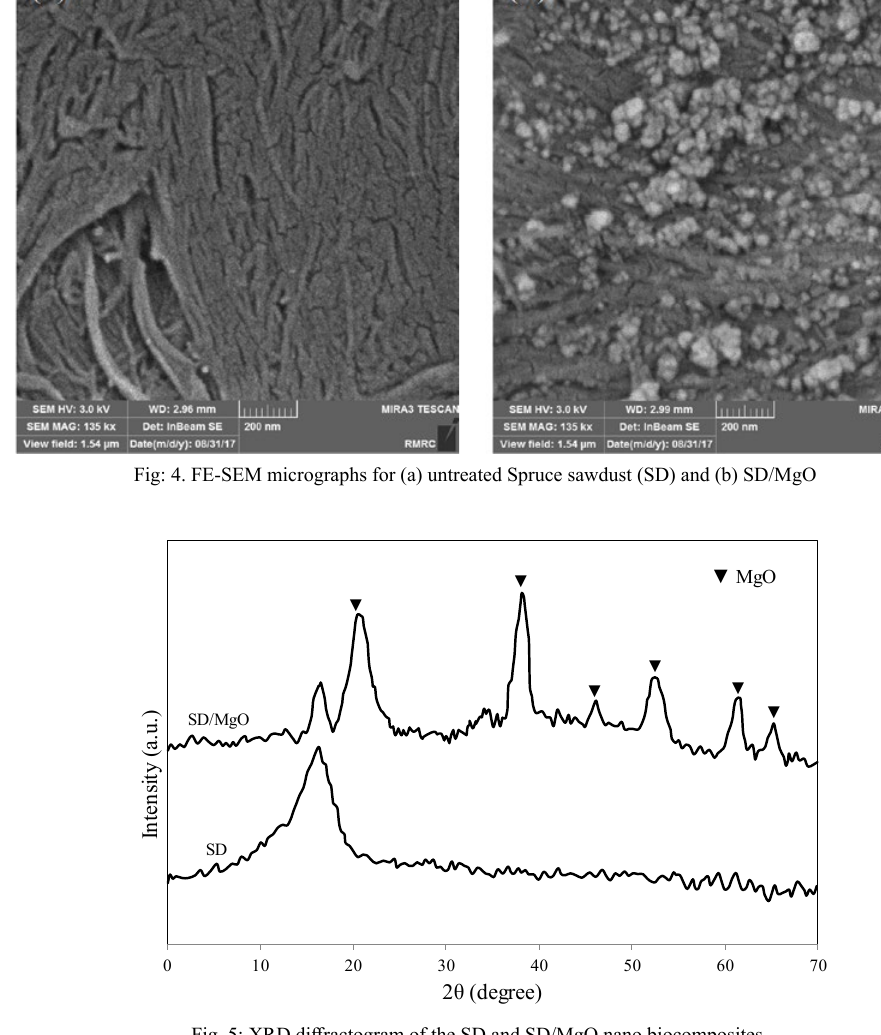
Fig. 5: XRD diffractogram of the SD and SD/MgO nano Fig. 5. XRD diffractogram of the SD and SD/MgO nano biocomposites.